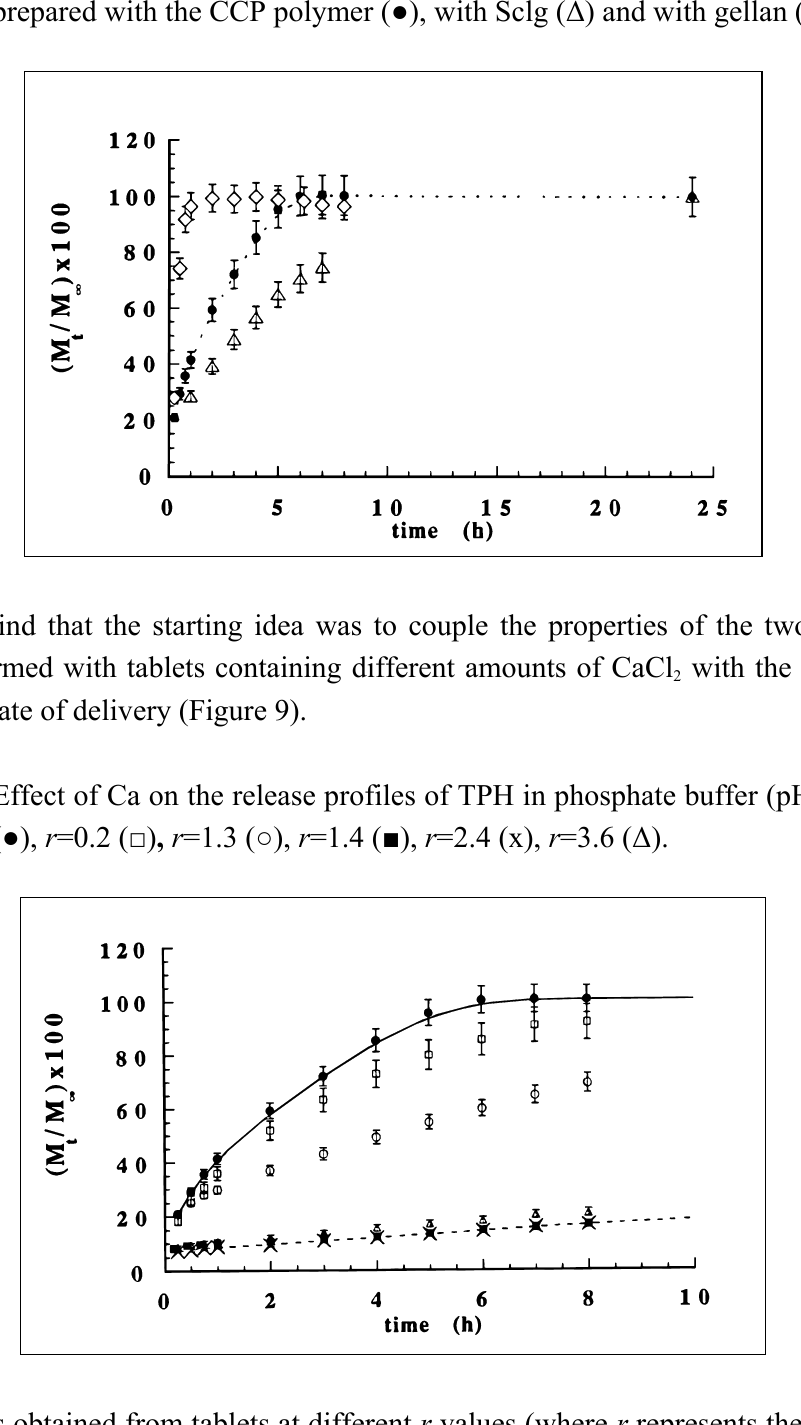
Figure 8. Release profiles of TPH in phosphate buffer (pH=7.4) at 37 °C from tablets